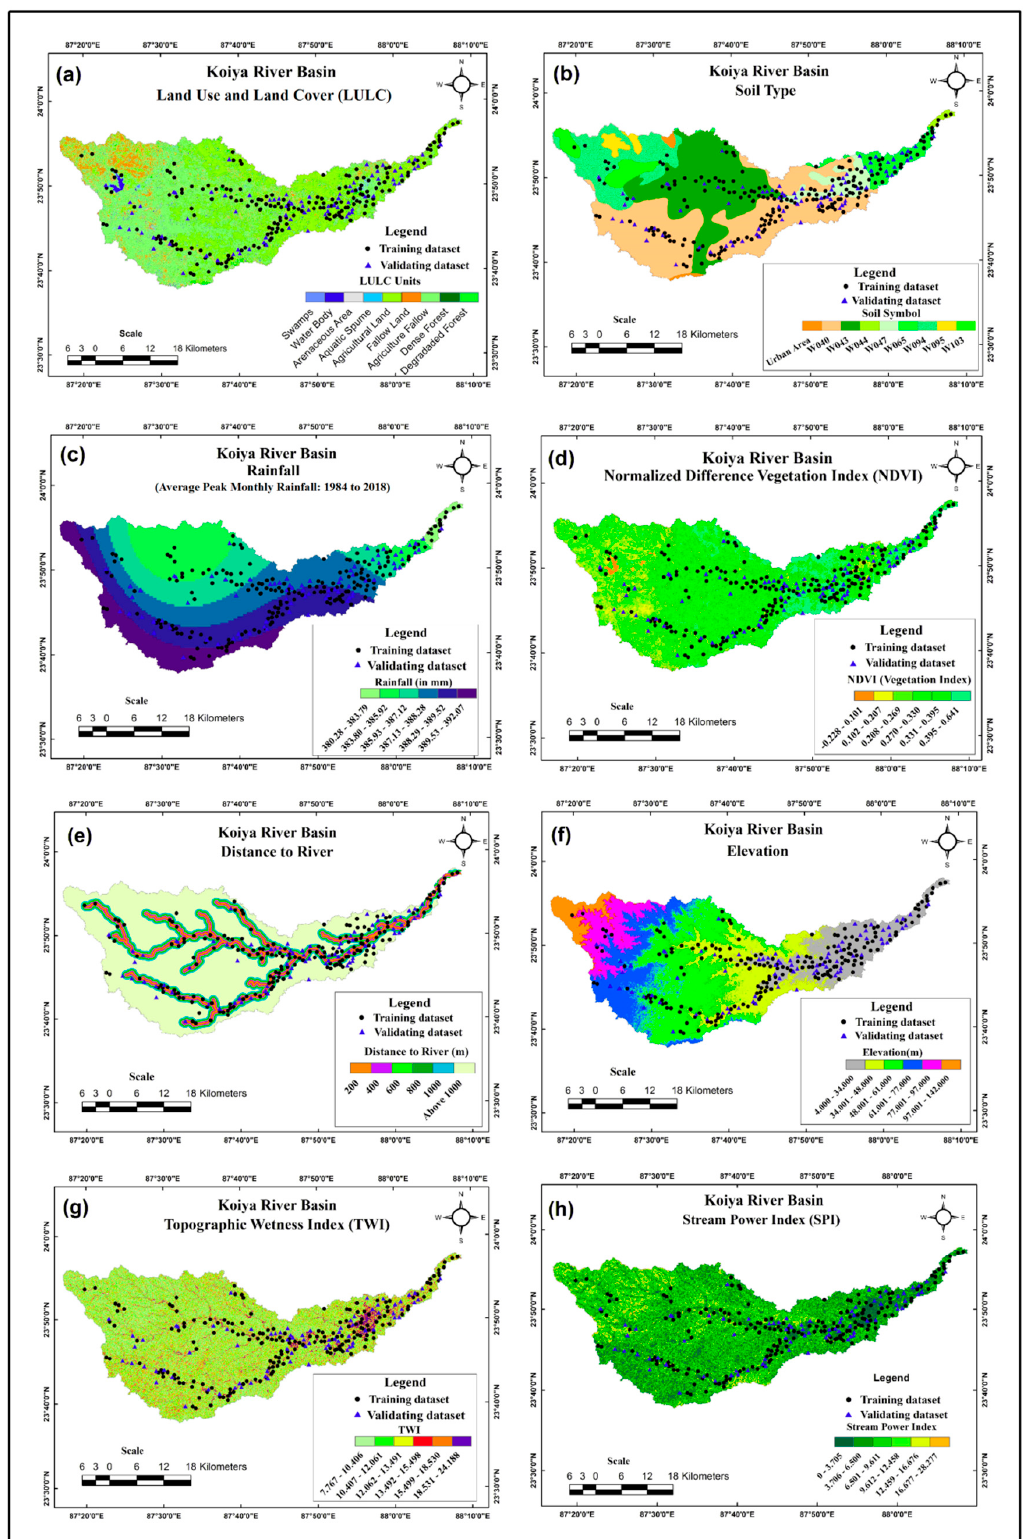
Figure 4. Flood causative factors; ( a ) land use land cover (LULC), ( b ) soil type, ( c ) rainfall, ( d ) normalized difference vegetation index (NDVI),( e ) distance to river,( f ) elevation, ( g ) topographic wetness index (TWI), and ( h ) stream power index (SPI).